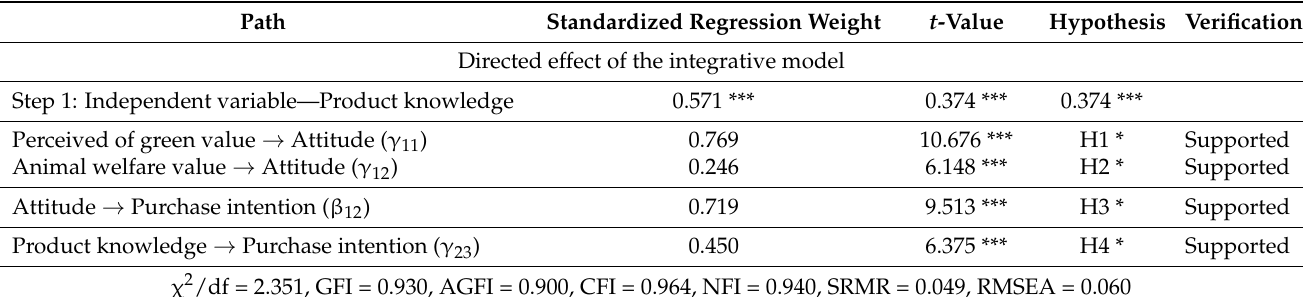
Figure 2. Results of structural equation modeling Note. *** p < 0.001. Table 5. The model’s standardized regression weights, t -values, and hypothesis.